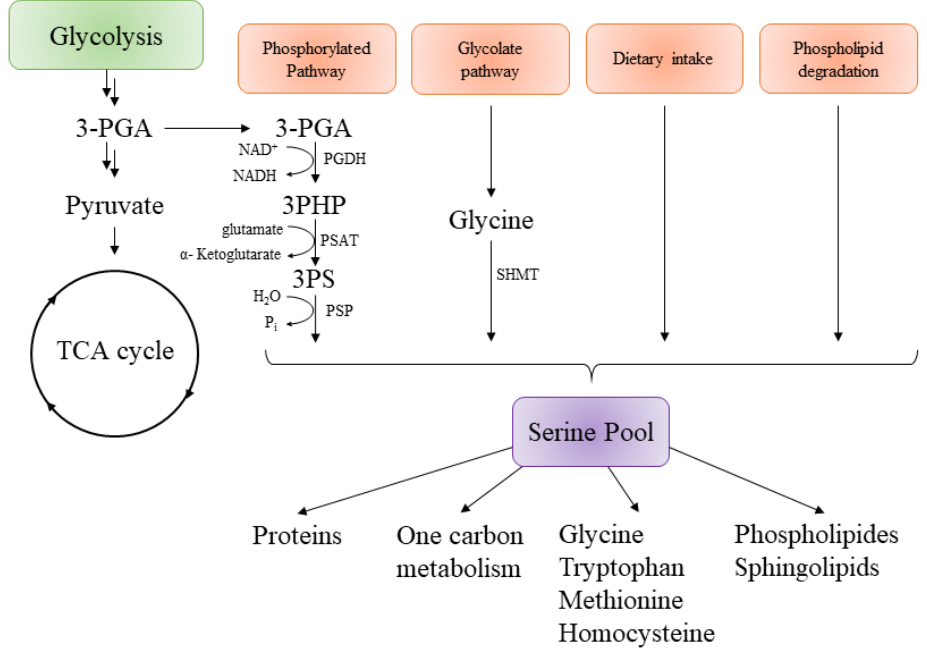
Figure 4. General representation of serine biosynthesis in different organisms and its connection with different metabolic pathways. 3-PGA, 3-phosphoglycerate; 3PHP, 3-phosphohydroxypyruvate; 3-PS, 3-Phospho- L -Serine; PGDH, Phosphoglycerate dehydrogenase; PSAT, Phosphoserine aminotransferase; PSP, Phosphoserine phoshatase; SHMT, Serine hydroxymethyltransferase; Pi, PO 3 − acid cycle or Krebs cycle